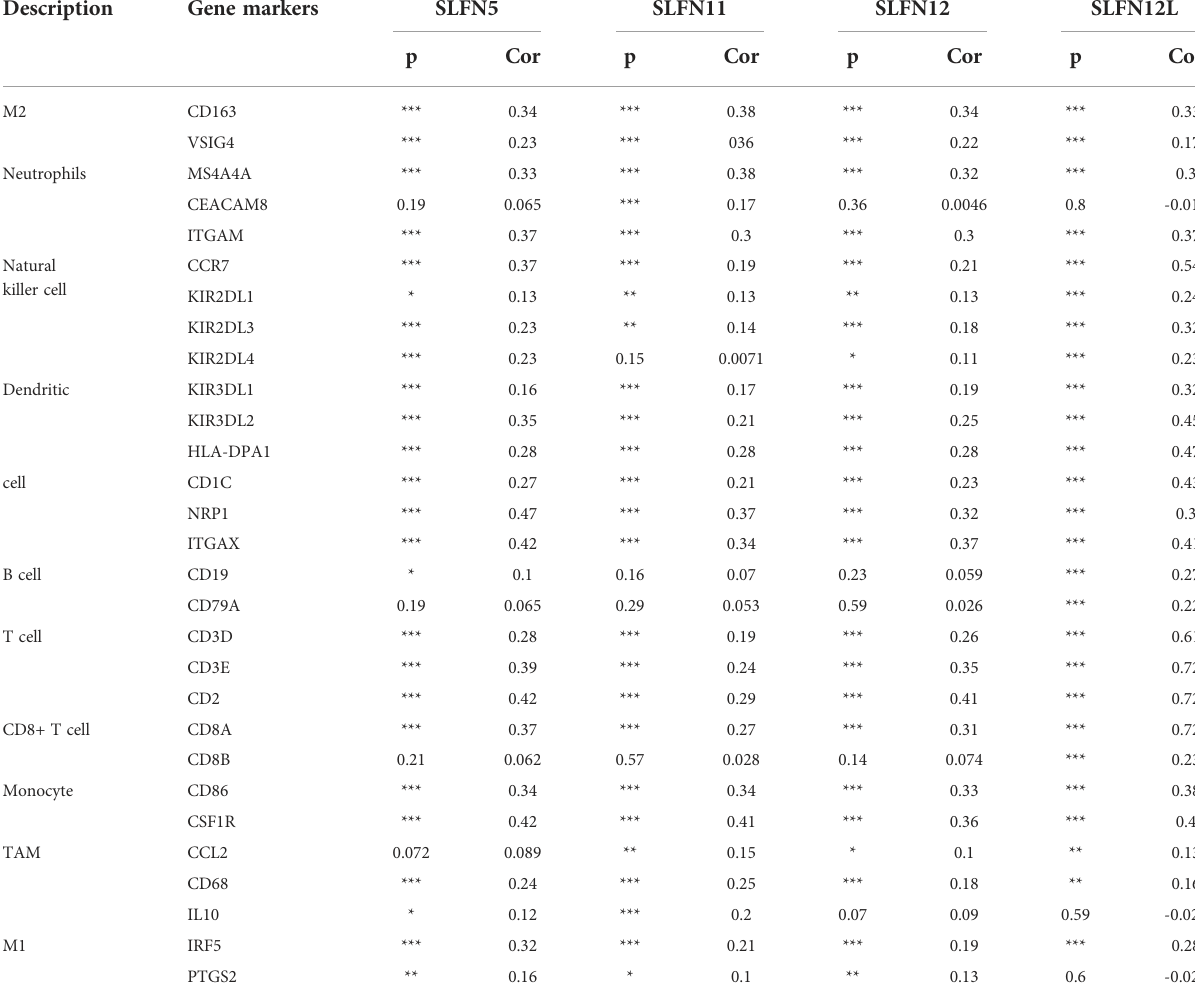
TABLE 4 Correlation analysis between SLFN and gene markers of immune cells in GEPIA.